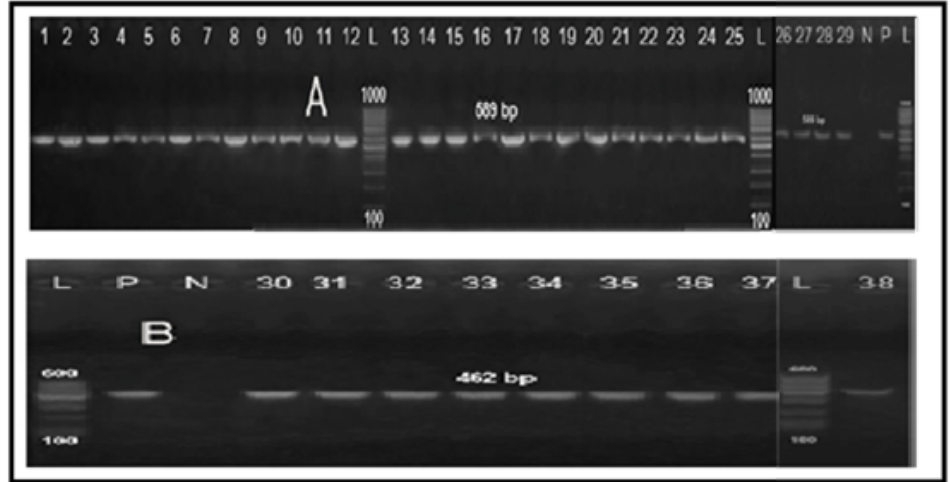
Figure 5. PCR amplification products of mapA gene specific for C. jejuni ( A ) and ceuE gene specific for C. coli ( B ). Lanes 1–11: C. jejuni from human origin, lanes 12–29: C. jejuni from chicken samples, lanes 30–31: C. coli from human samples, lane 32–38: C. coli from chicken origin, lane L: 100 bp DNA ladder “Marker”, lane P: positive controls ( C. jejuni NCTC11322 and C. coli NCTC11366), lane N: negative control (PCR-grade water).